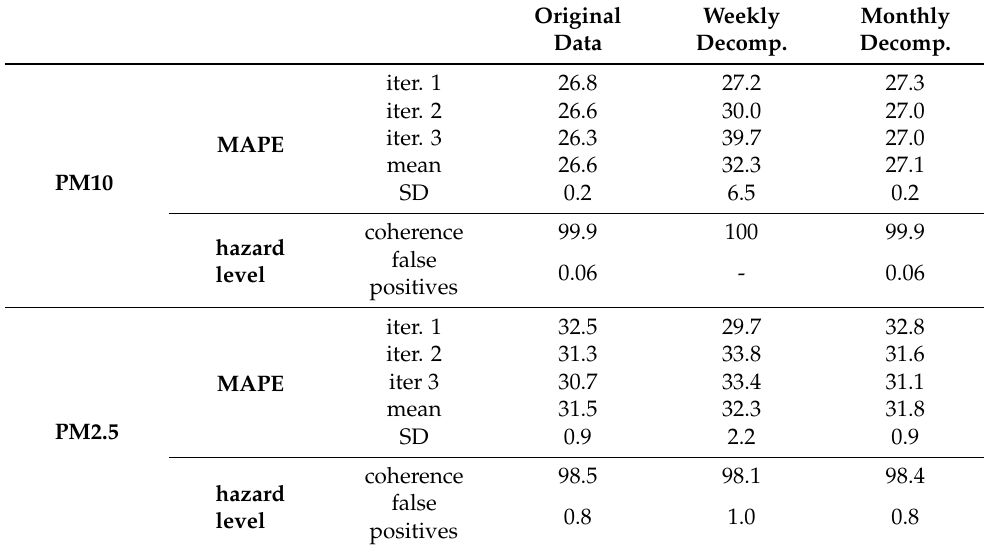
Table 1. Summary of the MLA results for PM10 and PM2.5 for the three iteration validations. The probability for the false positives and respective coherence for the health hazard levels defined by EEA [64] are also shown. All values (except for standard deviation (SD)) are in percentages.